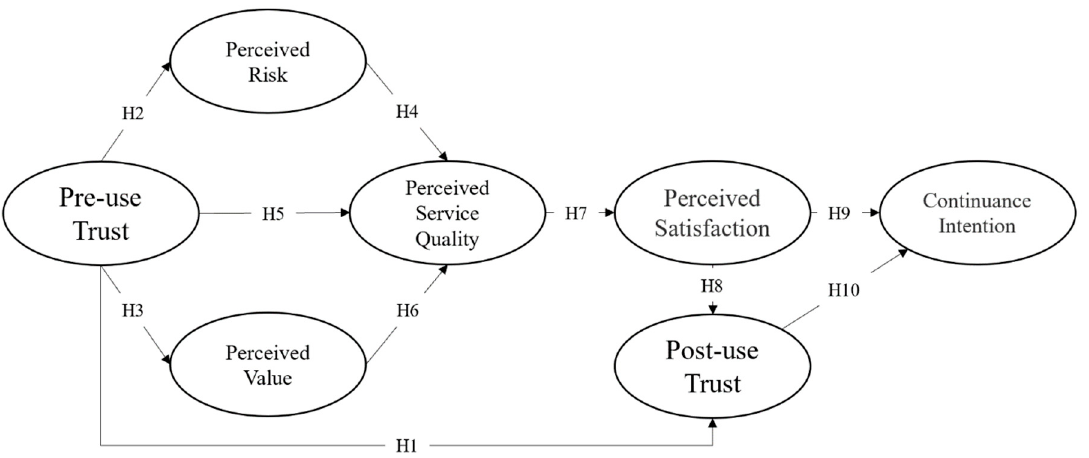
Figure 3. A model for continuance intention in congregate meal halls.